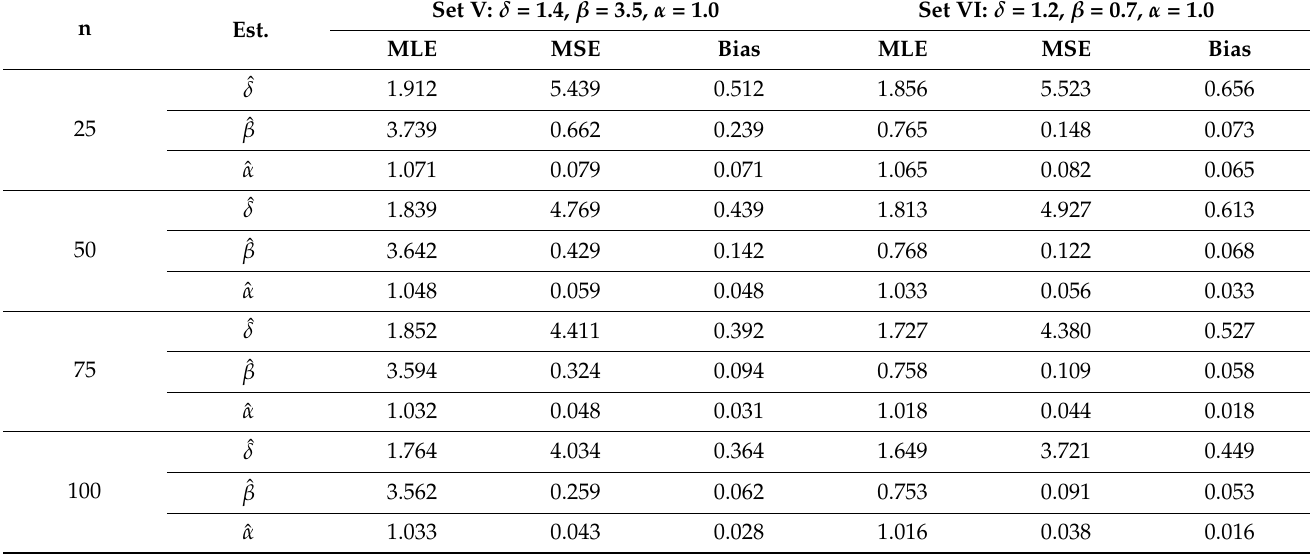
Table 4. SRs of the NGLog–Weib distribution for Set V and Set